Question: Briefly state, in one sentence, what is plotted here.
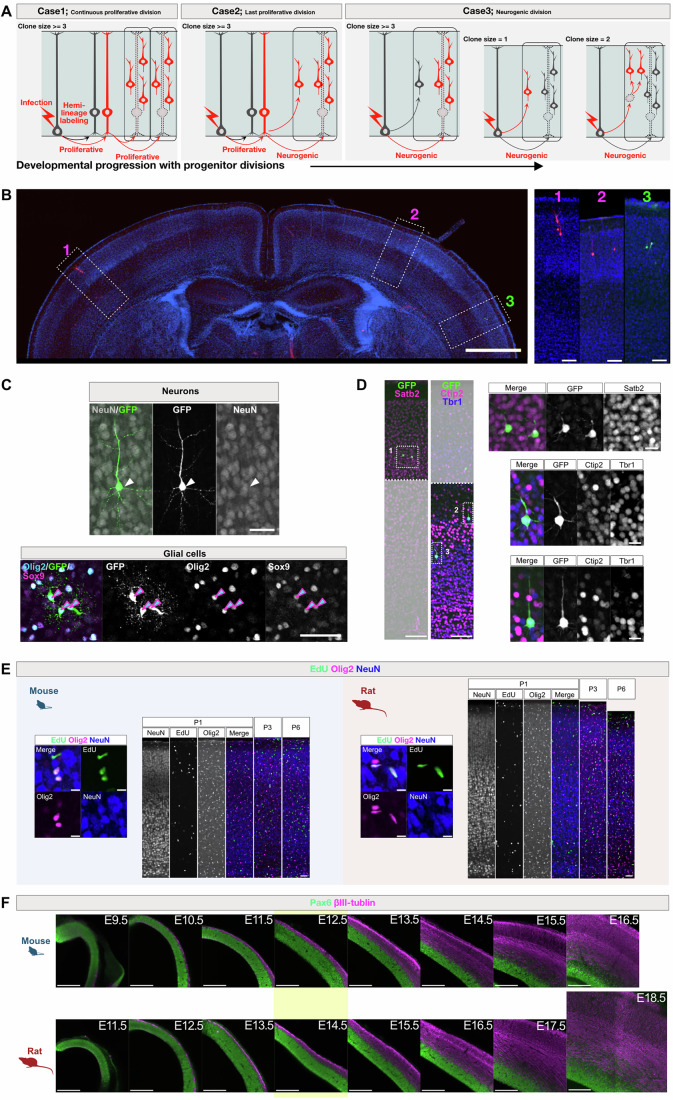
Answer: Clonal analysis of cortical RG progenitors in mice and rats from the onset to the end of excitatory neurogenesis, related to Fig. 2 . ( A ) Schematic representation of hemi-lineage labeling via retroviral gene transfer, illustrating three scenarios of progenitor labeling. Cortical progenitors initially divide symmetrically to expand their population before transitioning to neurogenesis. Radial glial (RG) progenitors begin producing neurons by switching from symmetric proliferative divisions to asymmetric neurogenic divisions. Eventually, RG progenitors terminate producing neurons to begin gliogenesis. A clonal “unit” of neurons is defined as sister excitatory neurons that share a common progenitor origin and are produced during the first and subsequent neurogenic divisions of the mother progenitor (rounded boxes). Case 1: The retroviral vector infects a progenitor undergoing symmetric proliferative divisions. This results in multiple clonal units being labeled within the same cell cluster. Case 2: The retroviral vector infects an RG progenitor at its last proliferative division before initiating neurogenesis. In this ideal case, the entire clonal unit of sister neurons is labeled. Case 3: The retroviral vector infects an RG progenitor that has already started neurogenic divisions. In this scenario, some members of the clonal unit are missing from the labeled cohort, resulting in an incomplete clone. Alternatively, only one neuron (direct neurogenesis) or two neurons (indirect neurogenesis via intermediate progenitors) may be labeled. Given the heterogeneity in cortical progenitor division statuses, actual experimental data represent a mixture of these three cases. In Case 3, where neurogenic progenitors dominate, half of the clones are expected to consist of one or two neurons. Therefore, twice the proportion of one- or two-neuron clones serves as an estimate of the ratio of neurogenic progenitors at the time of retroviral injection. ( B ) Representative coronal sec